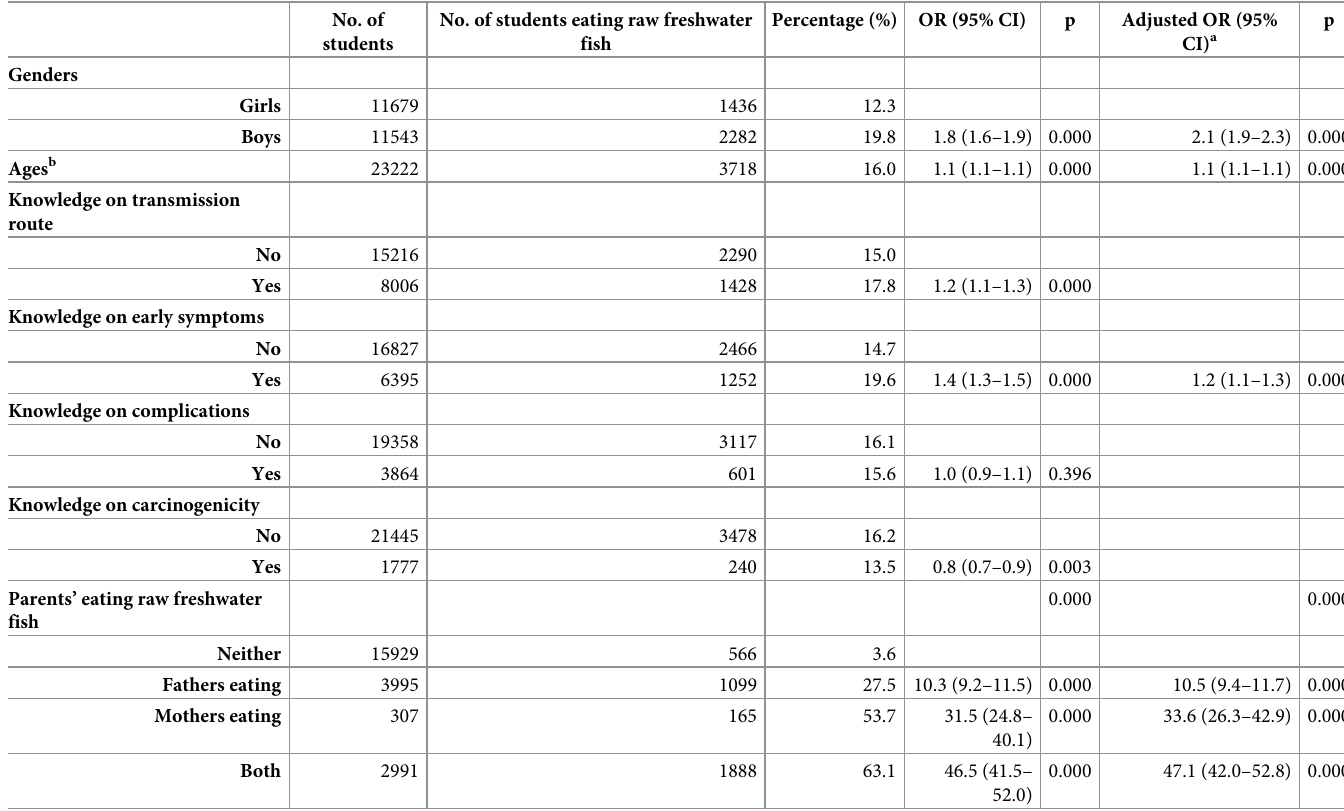
Table 2. Determinant of students’